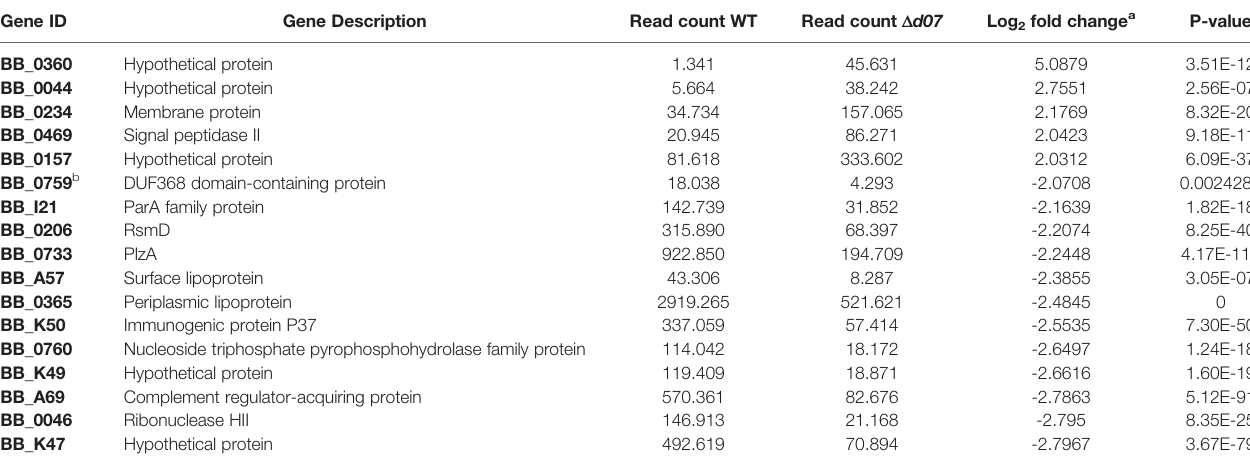
TABLE 5 | Genes differentially expressed by D d07 compared to wild type in vitro